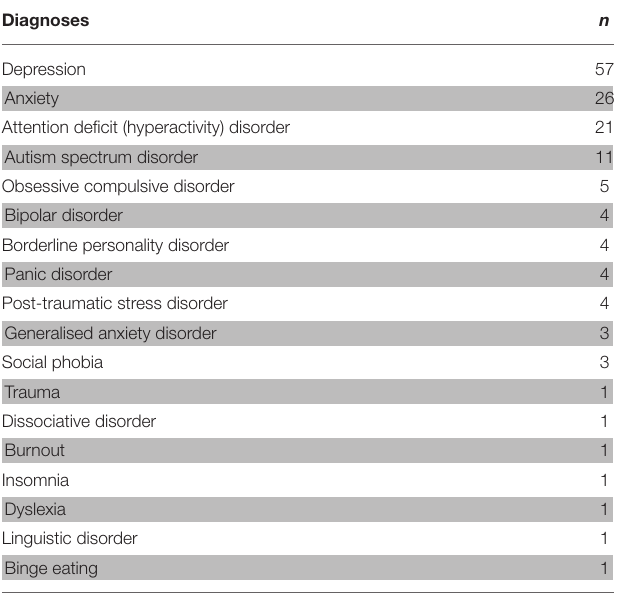
TABLE 1 | Self-reported formal diagnoses of a mental